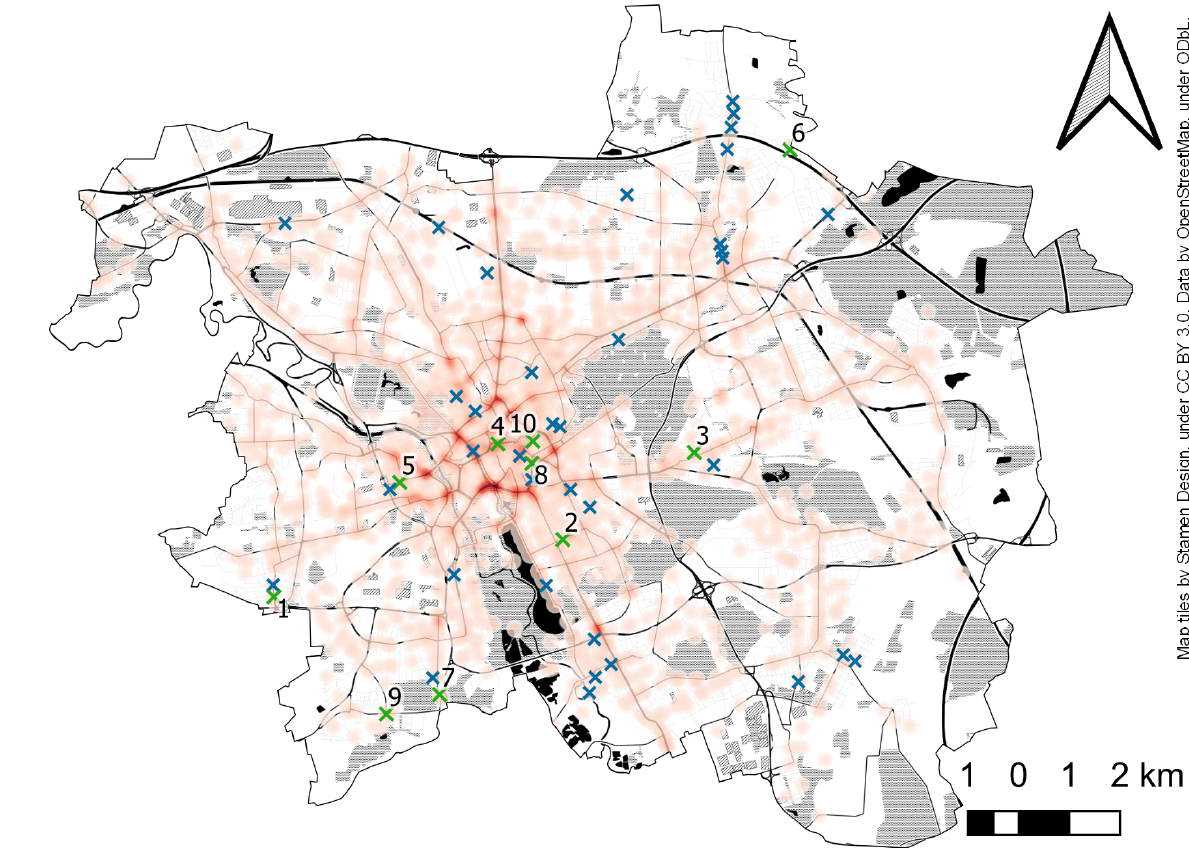
Figure 5. Overview of 5 % (crosses) and top ten (green crosses with labels) riskiest accident spots. The heatmap of absolute accident spots is in the background from figure 1 for comparison.